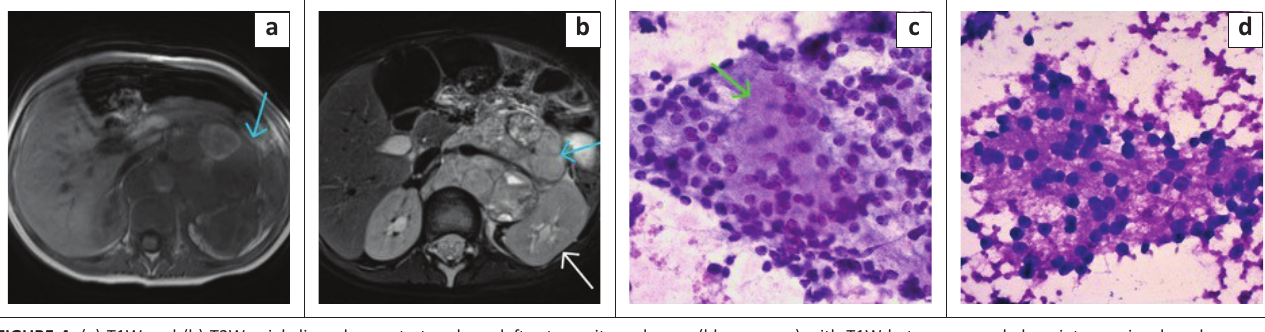
FIGURE 4: (a) T1W and (b) T2W axial slices demonstrate a large left retroperitoneal mass (blue arrows) with T1W heterogeneously hypointense signal, and areas of increased signal likely representing subacute to chronic haemorrhage; T2W heterogeneously hyperintense signal. The mass anteriorly crosses the midline, displacing and encasing vessels and posterolaterally abuts and displaces the left kidney (white arrow). No claw sign is present. Findings are consistent with a neuroblastoma. (c) Shows a Papanicolaou stain confirming a neuroblastoma with neuroblasts lying pink fibrillary stroma (neuropil) (green arrow) (20×). (d) Shows a Giemsa stain with metachromatic, fibrillary neuropil with small blue neuroblasts